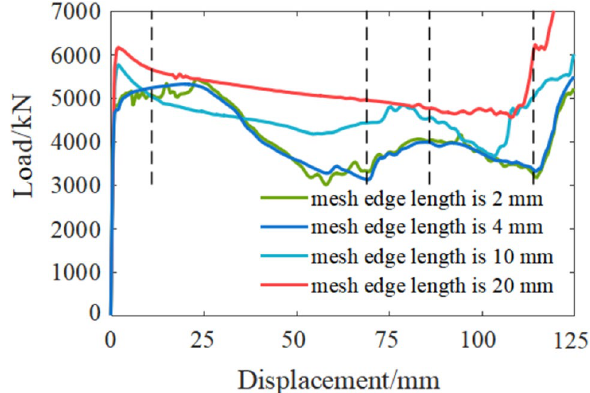
Figure 5. Simulation results of different mesh size.